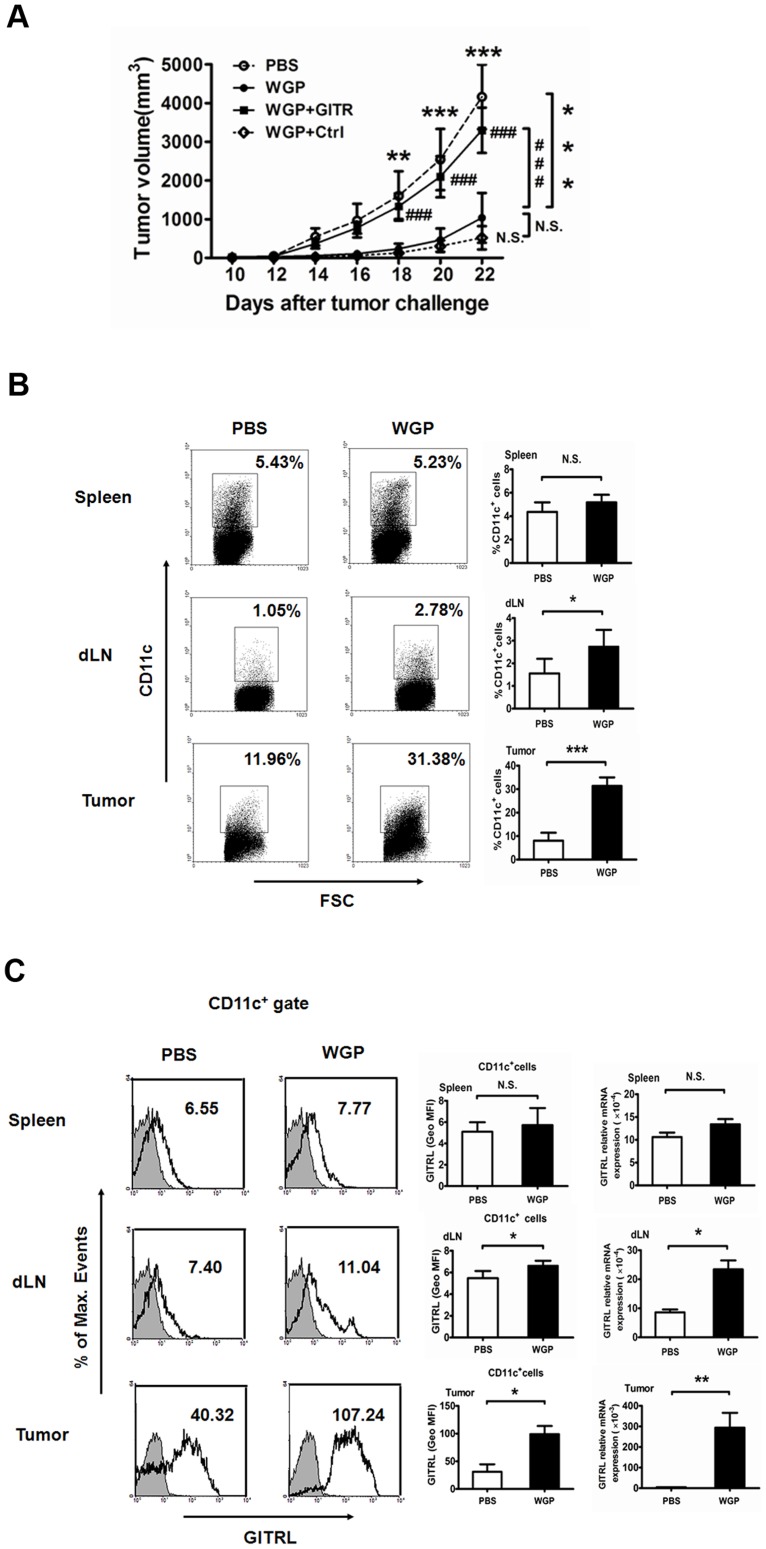
WGP treatment up-regulates GITRL expression on DCs in tumor-bearing C57BL/6 mice.(A) Groups of mice (n = 6) bearing established Lewis lung carcinoma were treated as described in Materials and Methods. Tumors were measured with a caliper at indicated time. (B) The proportions of CD11c+ DCs in spleens, draining lymph nodes (dLN) and tumor tissues from WGP-treated or untreated mice were analyzed using flow cytometry. (C) Expression of GITRL on CD11c+ cells in spleens, draining lymph nodes and tumor sites treated with or without WGP were assessed by flow cytometry. Histograms are gated on CD11c+ cells (isotype: solid gray). RNAs extracted from spleens, draining lymph nodes and tumors were subjected to qRT-PCR for GITRL expression. Numbers indicate percentages of events in gate (dot plot) or geometric mean fluorescence intensity (GeoMFI; histograms). Results are expressed as mean ± SD. ***P<0.001, **P<0.01, *P<0.05, ###P<0.001, N.S. represents no significance between columns.